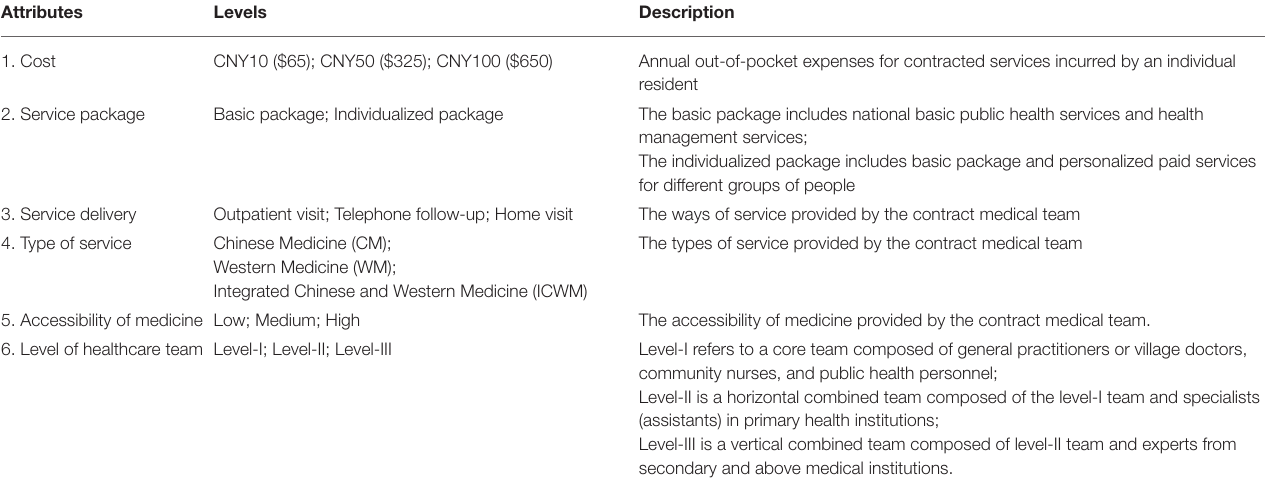
TABLE 1 | Attributes and levels used in the DCE.